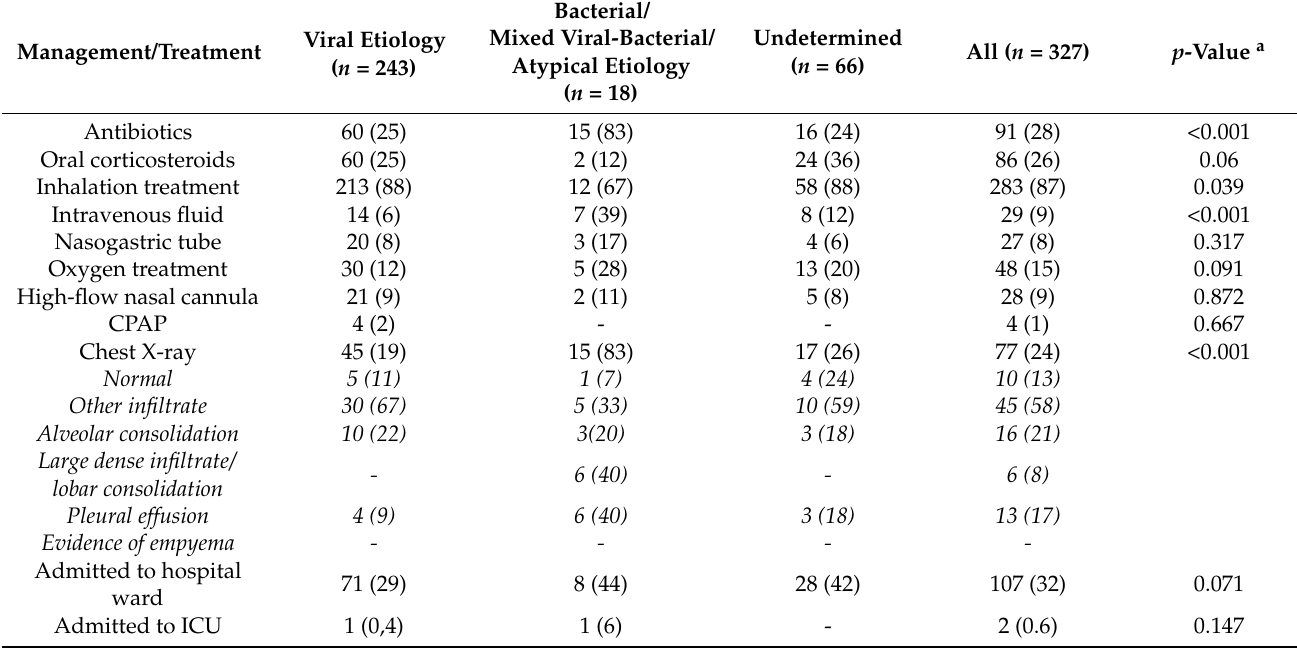
Table 2. Management of study participants according to the TREND etiology algorithm